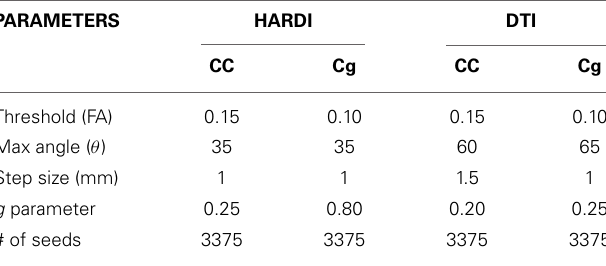
Table 1 | Parameters used for HARDI and DTI real-time tractography of the CC and Cg fiber